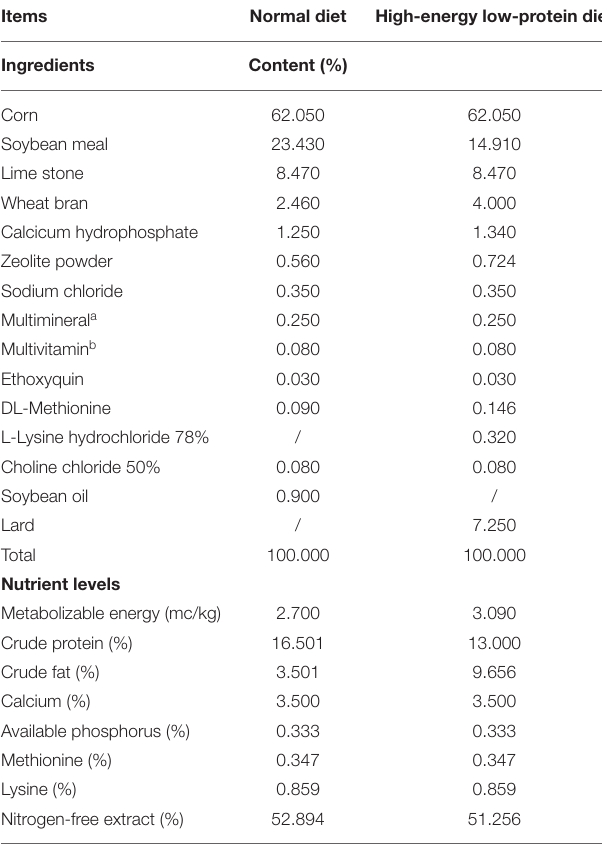
TABLE 2 | Composition and nutritional levels of basal diets of aged laying hens.